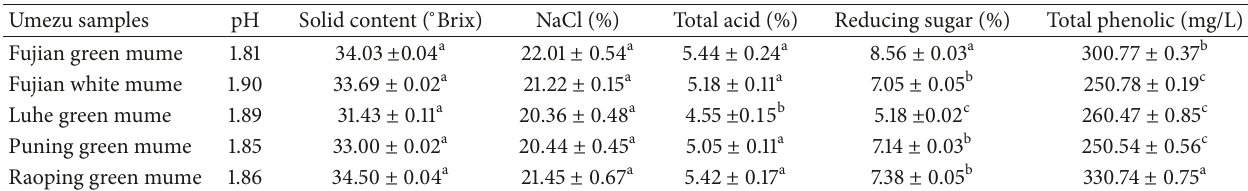
Table 1: Proximate composition of umezu from different factories.